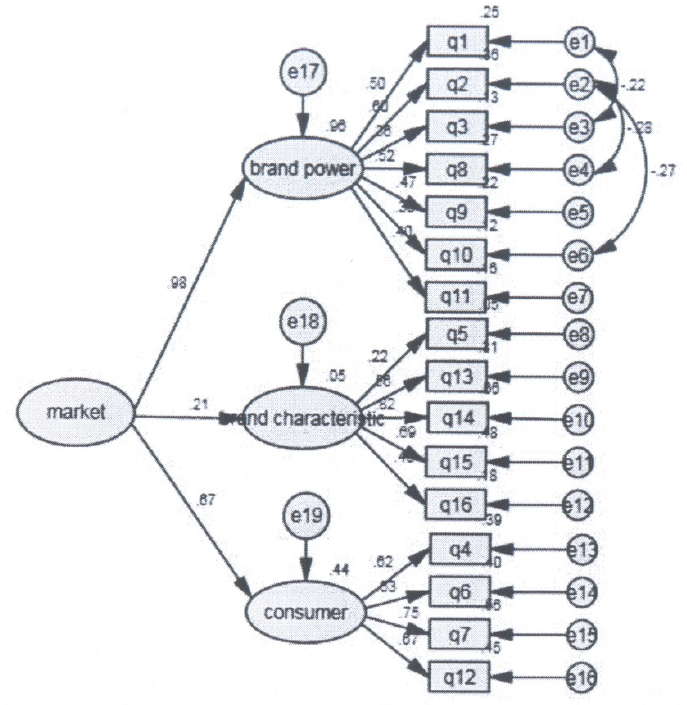
Fig. 3. The results of structural equation modeling